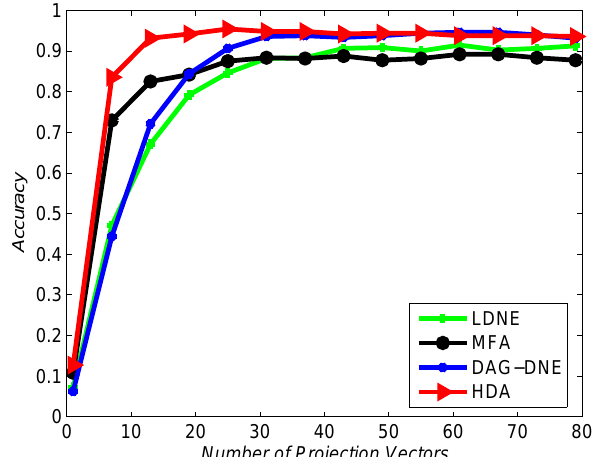
Figure 10. Accuracy vs. Number of Projection Vectors on the Olivetti Research Lab (ORL) dataset under K = 1.